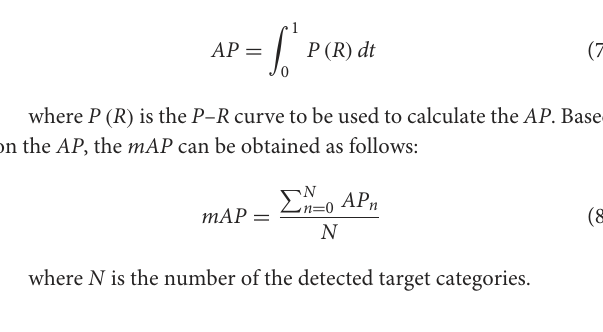
classified as positive examples, and FalseNegatives denotes the targets incorrectly classified as negative